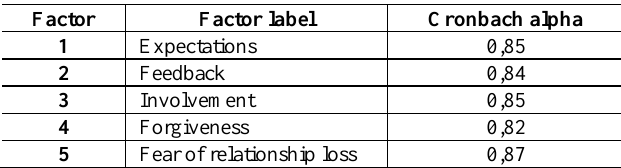
Table 1: Cronbach alpha values